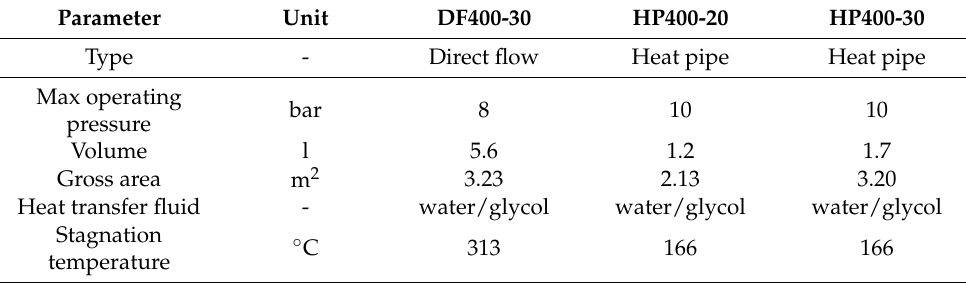
Table 2. Technical data of Kingspan Thermomax solar collector